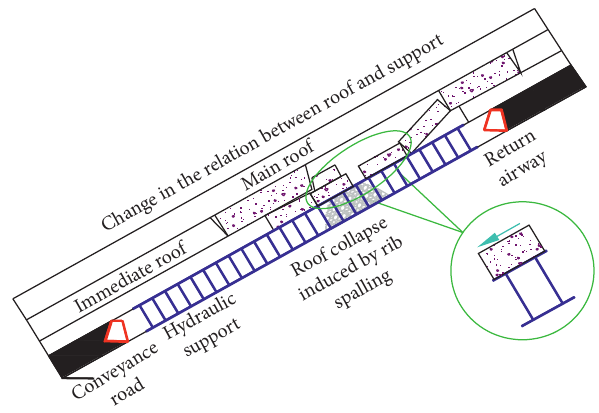
Figure 12: Change in the relation between the immediate roof and support caused by spalling roof collapse.